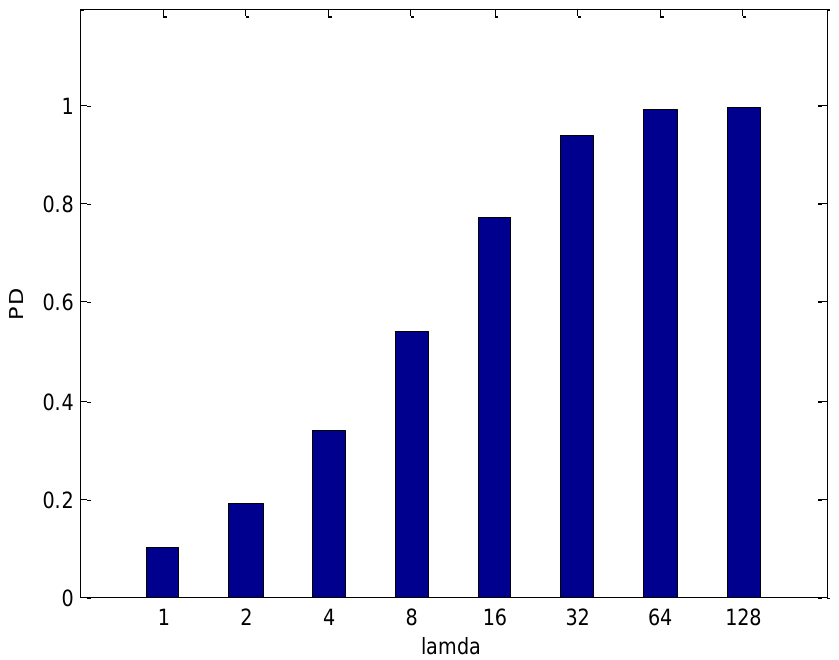
) evaluation results of the target with λ E P evaluation results of the target with . Figure 4. The E ( P D i i D